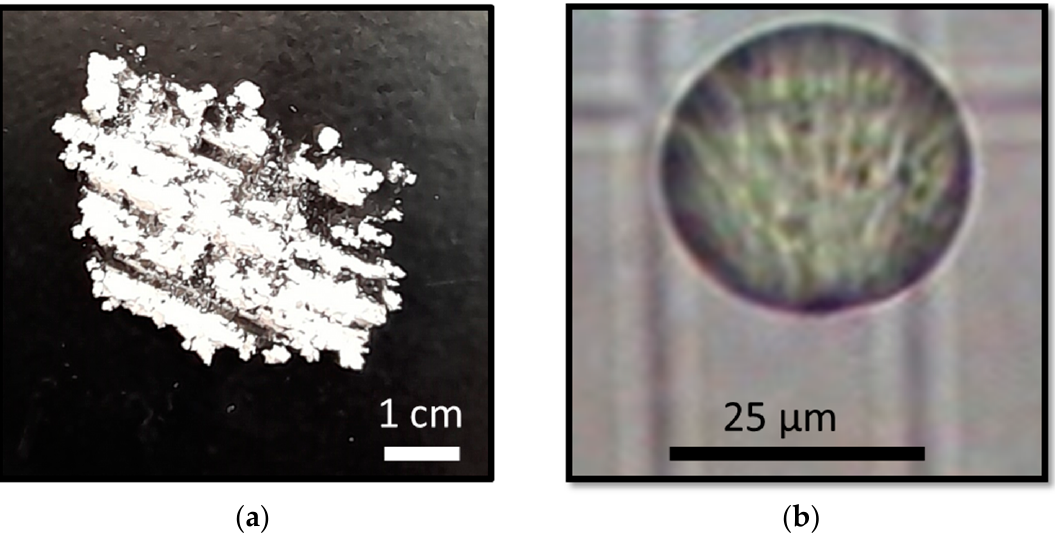
Figure 1. Representative photographs ( a , c , e ) and micrographs ( b , d , f ) of the alginate-based materi- als prepared: ( a , b ) Alginate spheres, diameter = 991 ± 72 μ m (n = 30); ( c , d ) Alginate spheres with encapsulated graphene, diameter = 1200 ± 98 μ m (n = 30); ( e , f ) Alginate spheres with encapsulated activated carbon, diameter = 1722 ± 115 μ m (n = 30). Micrographs were obtained using a Canon PowerShot A640 camera coupled to a Zeiss Axiotech microscope and analyzed for diameter length using Axionvision software (version 4.8).